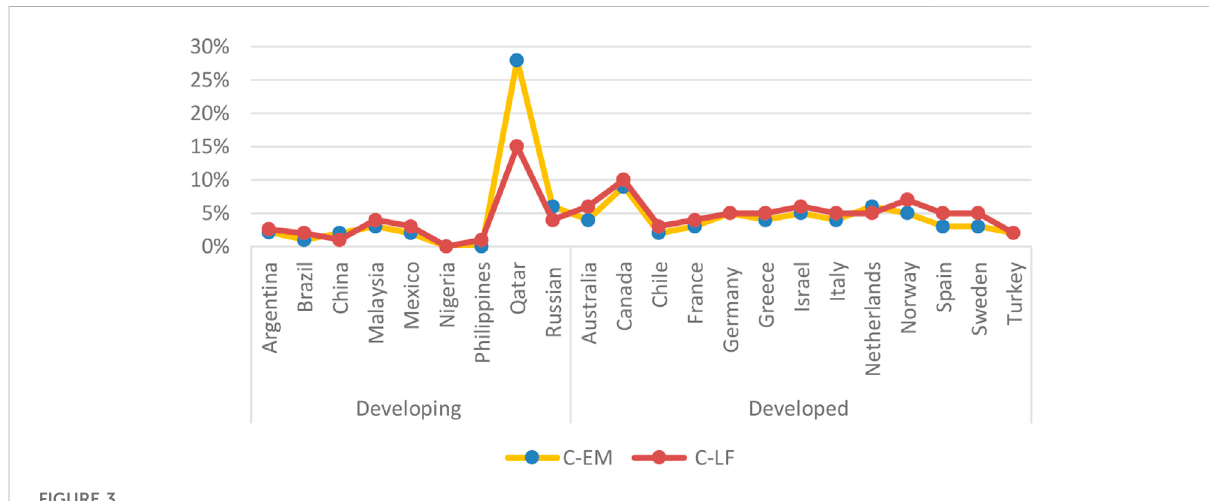
FIGURE 3 CEM of developing and developed